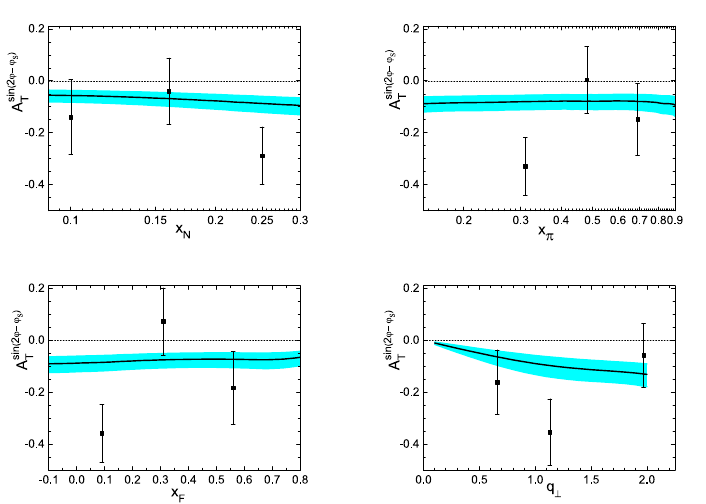
in the π − N ↑ Drell-Yan process calculated from the SIYY Figure 1. The asymmetry A sin(2 φ − φ S ) T parametrization on the nonperturbative form factor. The four figures correspond to the asymmetries as functions of x N (upper left), x π (upper right), x F (lower left) and q (lower right). The solid lines ⊥ show the results from the central values of the parameters, while the shaded area show the uncertainty bands determined by the uncertainties of the parameters. The solid squares represent the COMPASS data for